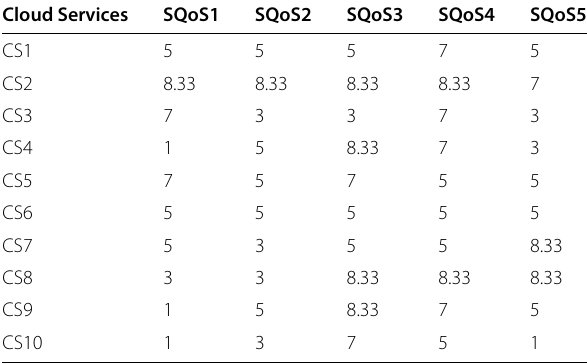
Table 5 Decision Matrix with Numerical Crisp Values Cloud Services